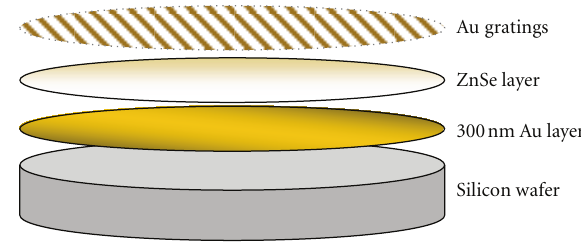
Figure 10: Illustration of the fabrication steps.